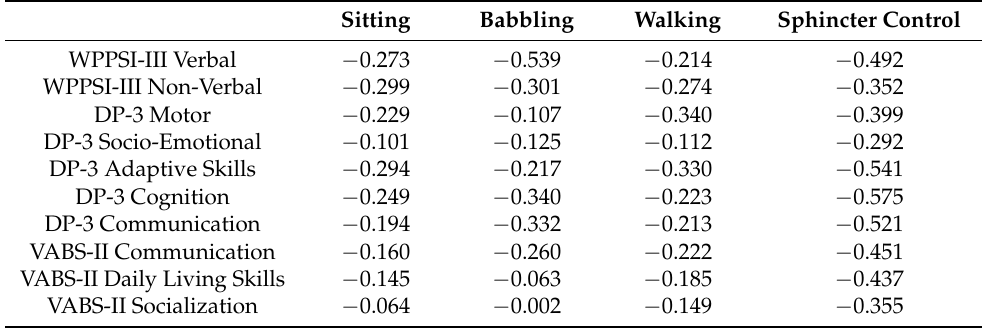
Table 6. Correlations between developmental milestones and cognitive, language, adaptive, and motor skills in the School-age group. N = 53.